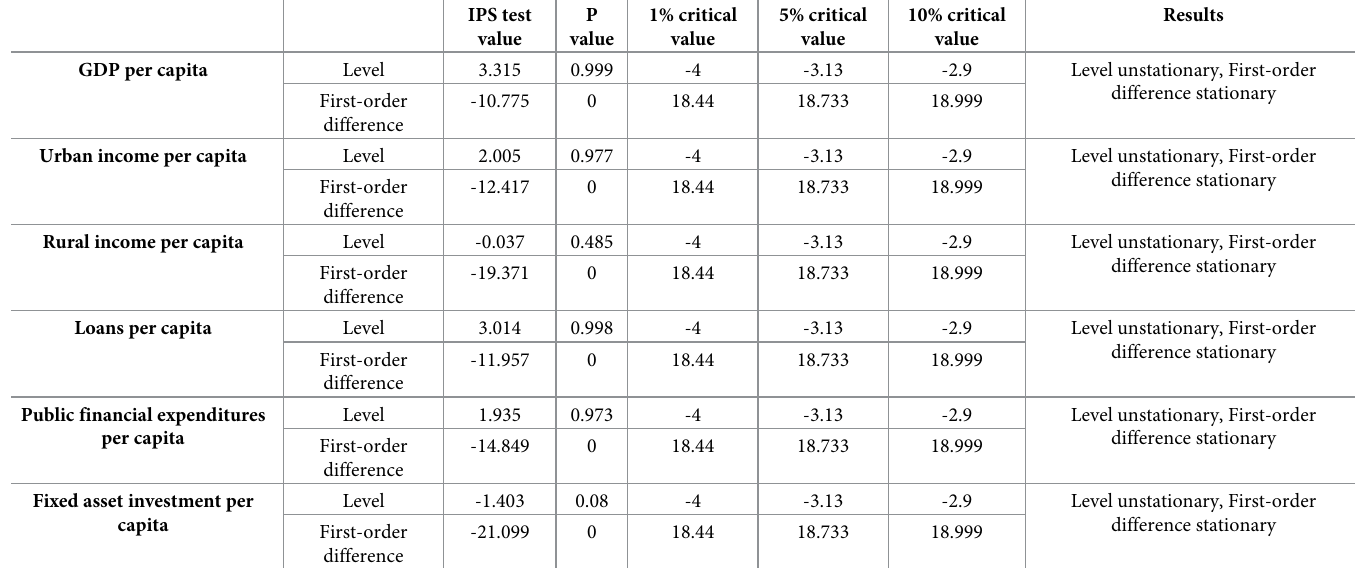
Table 3. The stationary test results of each variable